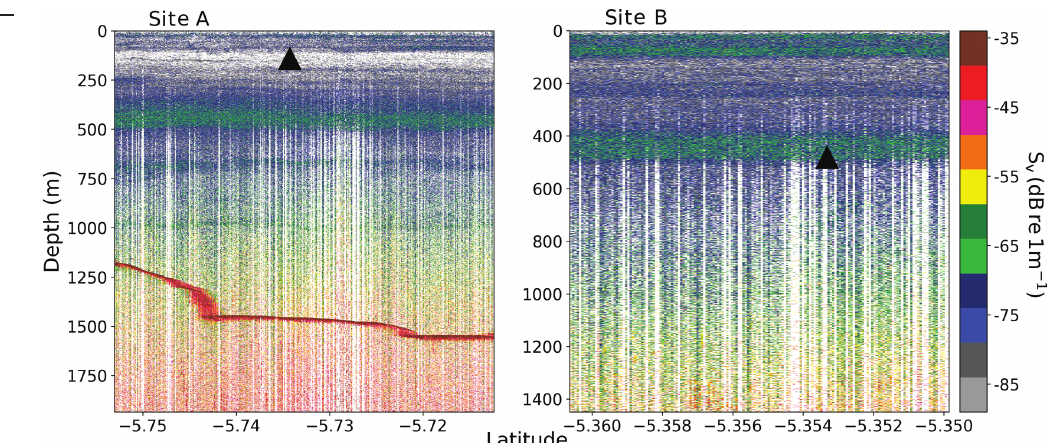
Location of survey conducted in 2016. Left shows depth contours based on the 2014 GEBCO bathymetry grid, right shows depth contours derived from SRTM30 PLUS v11. Both grids indicate the presence of a conical seamount (A) c.20 km NW of the Great Chagos Bank. No feature was detected by the 2016 survey. Around 40 km north of this, is another predicted seamount (B), again not detected on the 2016 survey. Feature B is predicted by the GEBCO grid but is not shown in the SRTM30 PLUS grid (although present in previous versions). Map projection UTM zone 43 south (epsg:32743).